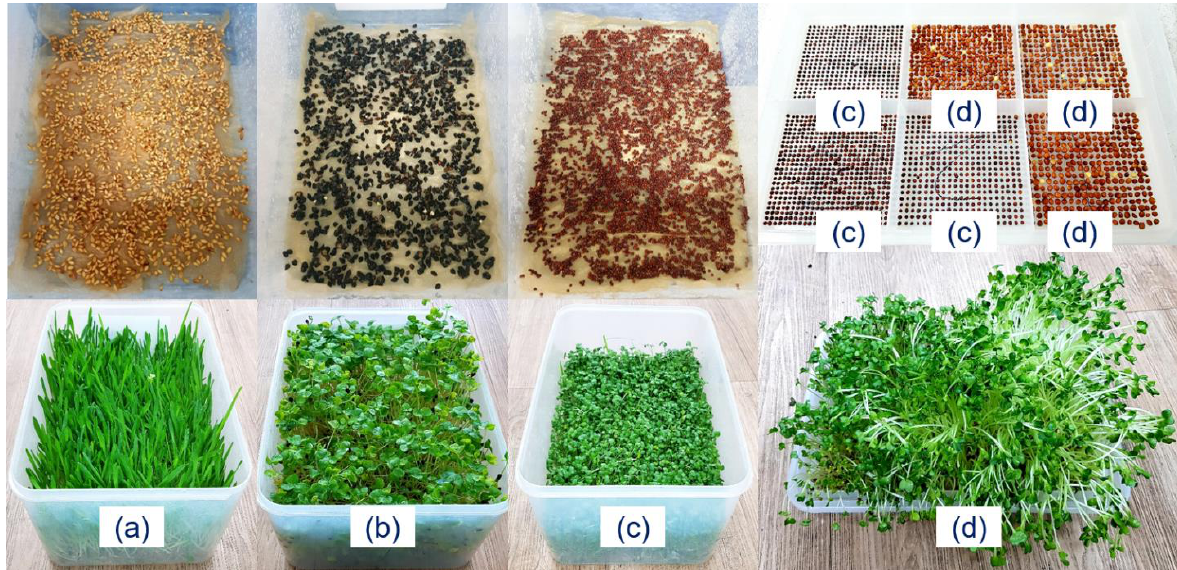
Figure 3. Efficacy of wastewater from ABFT tank including microalgae ( Chlorella ellipsoidea and Scenedesmus dimorphus ) in enhancing growth of leafy vegetables. (a) Barley ( Hordeum vulgare ), (b) Buckwheat ( Fagopyrum esculentum ), (c) Pak choi ( Brassica rapa ) and (d) Radish sprouts ( Raphanus sativus ). Three independents were performed. Each seed was purchased from an agriculture company (Chanamu Co., Republic of Korea) and the experiment was performed for 14 days in accordance with the